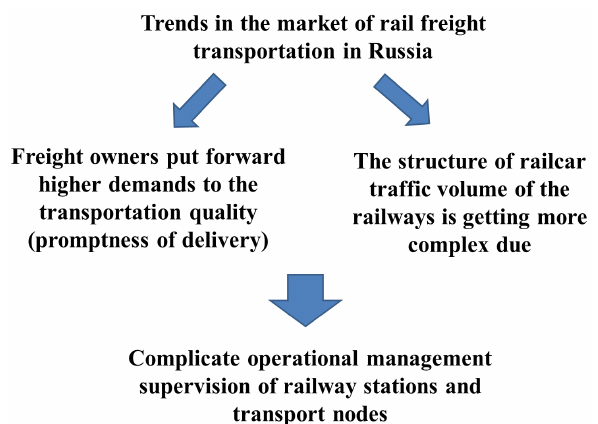
Figure 2: Main trends in the market of rail freight transportation in